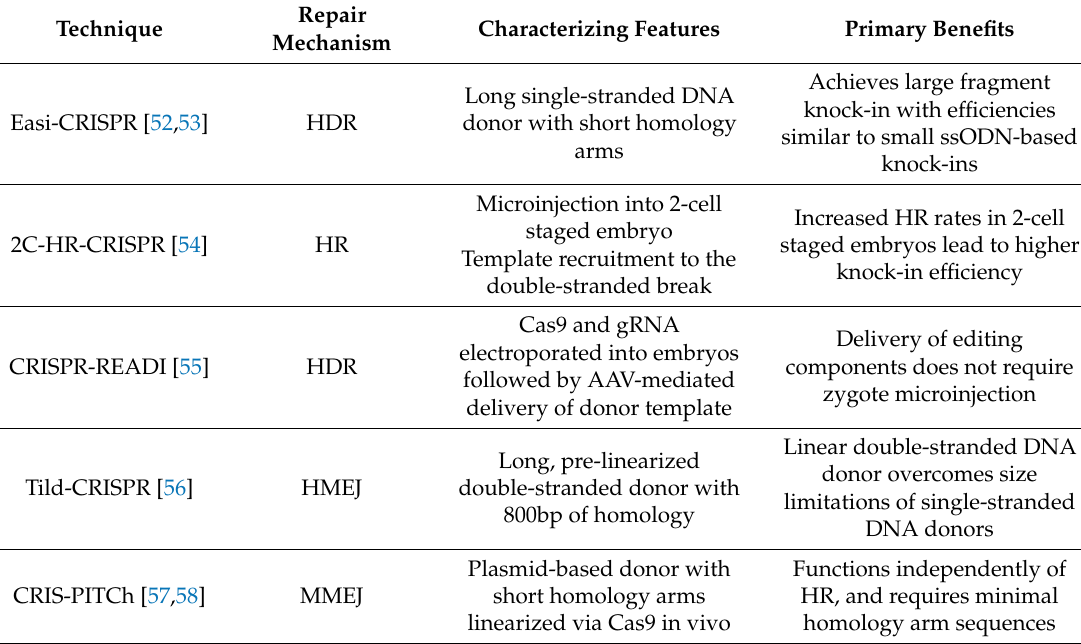
Table 1. Summary of techniques